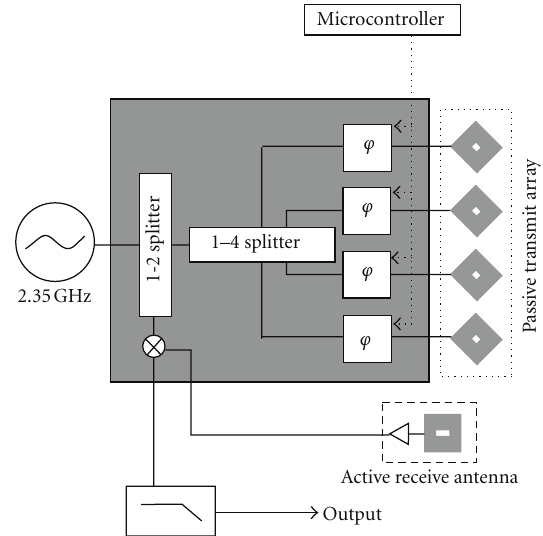
Figure 1: Block diagram of the wearable radar